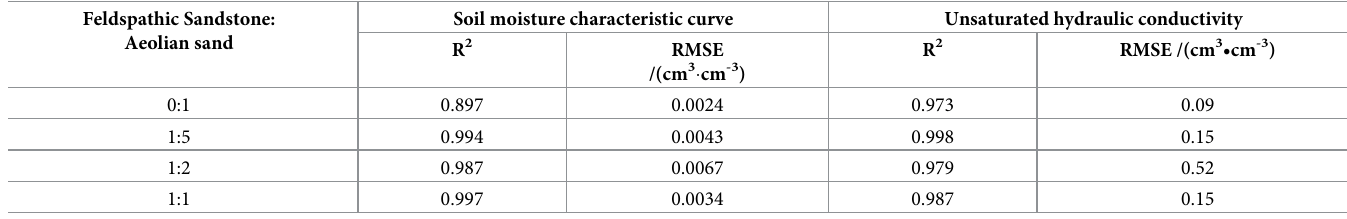
Table 3. Precision parameters of fractal model predicting soil properties. Feldspathic Sandstone: Aeolian